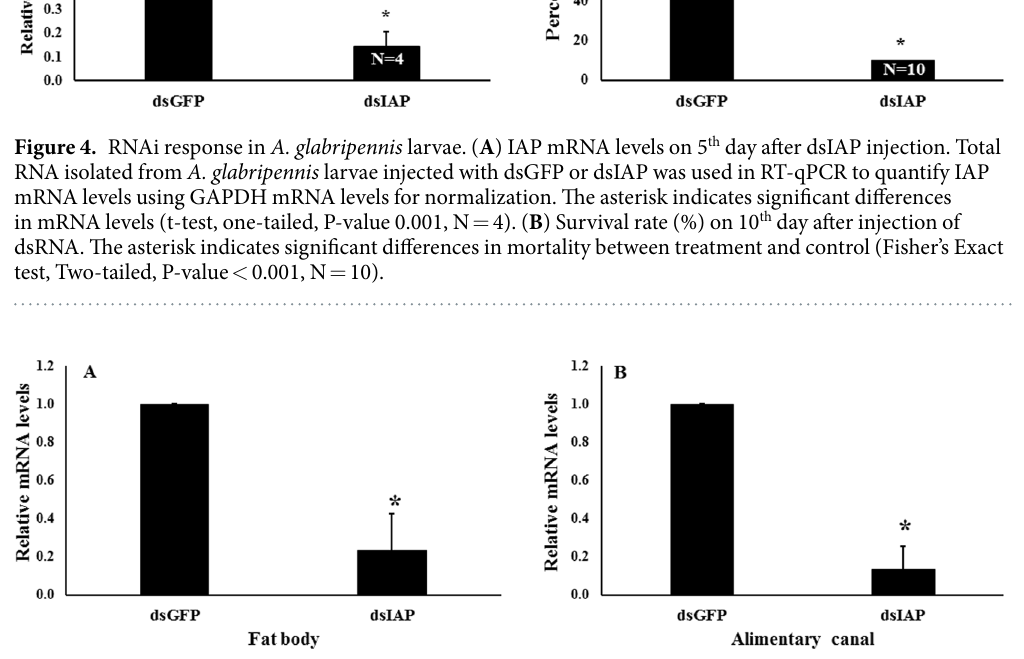
Figure 5. Relative IAP mRNA levels in the fat body and alimentary canal of larvae on 5 th day after dsIAP injection. ( A ) Relative IAP mRNA levels in the fat body. The asterisk indicates significant differences in mRNA levels (t-test, One-tailed, P-value = 0.000114, N = 3). ( B ) Relative IAP mRNA levels in the alimentary canal. The asterisk indicates significant differences in mRNA levels (t-test, One-tailed P-value = 0.00118, N =